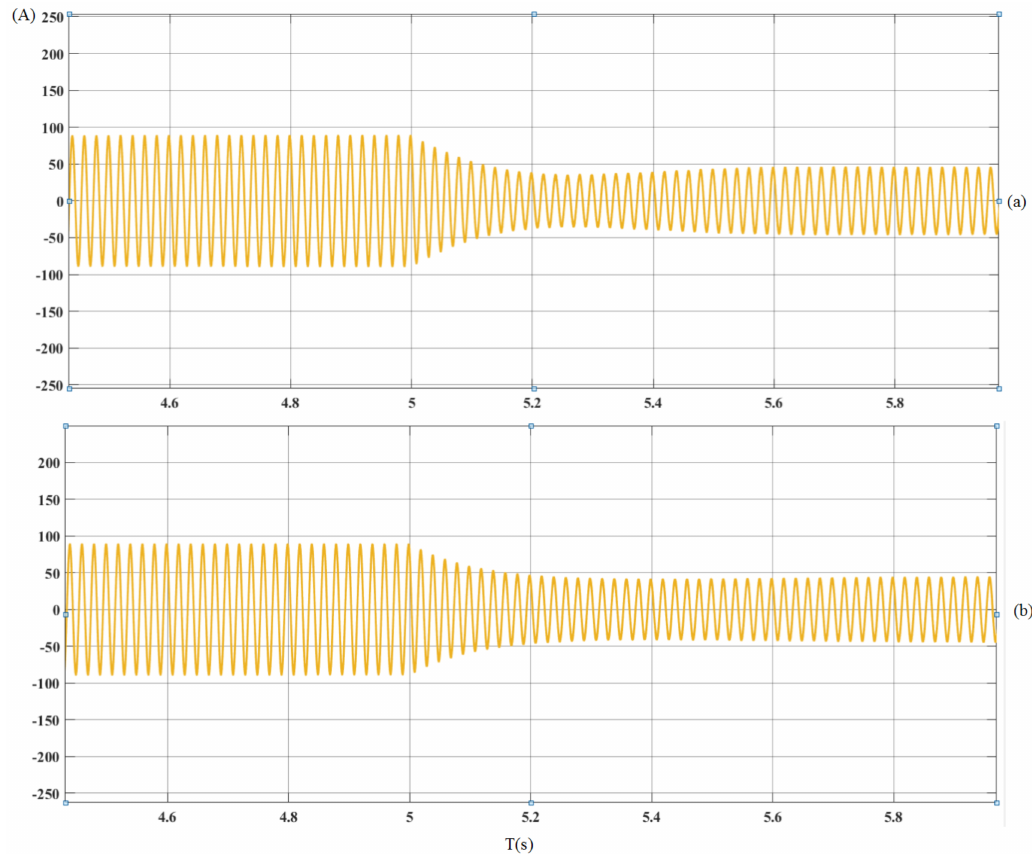
Figure 22. A-phase current waveforms when the load suddenly decreases: ( a ) controlled by the direct power control method; ( b ) controlled by the nonlinear feed-forward PID control